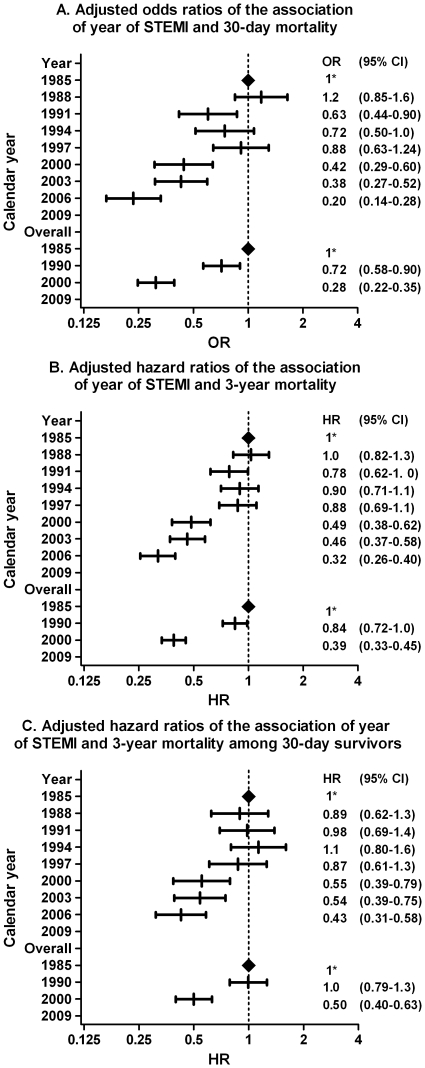
Adjusted odds or hazard ratios of secular trends in mortality after STEMI at 30-days (Figure 3A), at 3-year (Figure 3B), and at 3-year among 30-day survivors (Figure 3C).The upper part of the figure compares changes in mortality in time periods of three year, the lower part among patients hospitalised between 1985–1990; 1990–2000; and 2000–2008 *Reference category for the subsequent ratios CI, confidence interval; HR, Hazard ratio; OR, Odds ratio, STEMI, ST-elevation myocardial infarction